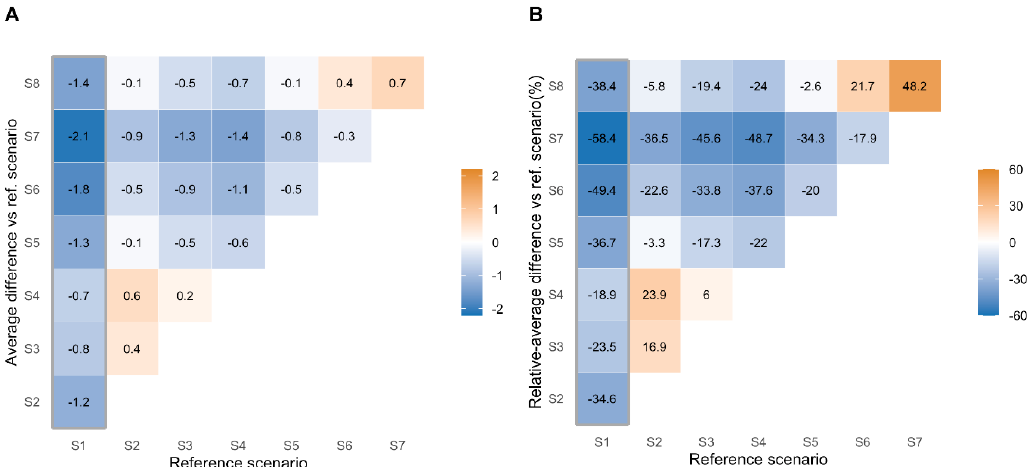
Figure 4. Vaccine willingness across scenarios among hesitating healthcare workers. Absolute ( A ) and relative ( B ) differences of the average score for vaccine-willingness (scale from 1 to 4) between a reference scenario with an ideal vaccine candidate (abscissa) and subsequent scenarios (ordinate) among hesitating 2240 participants ( A ). In ( B ), the relative percentage of variation in mean difference is given.